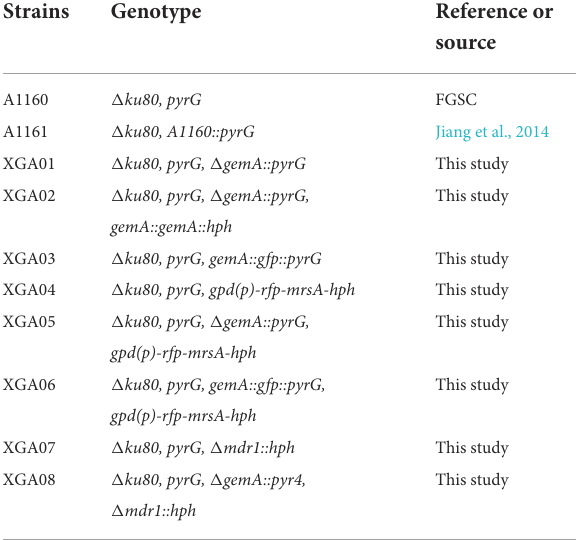
TABLE 1 Aspergillus fumigatus strains used in this